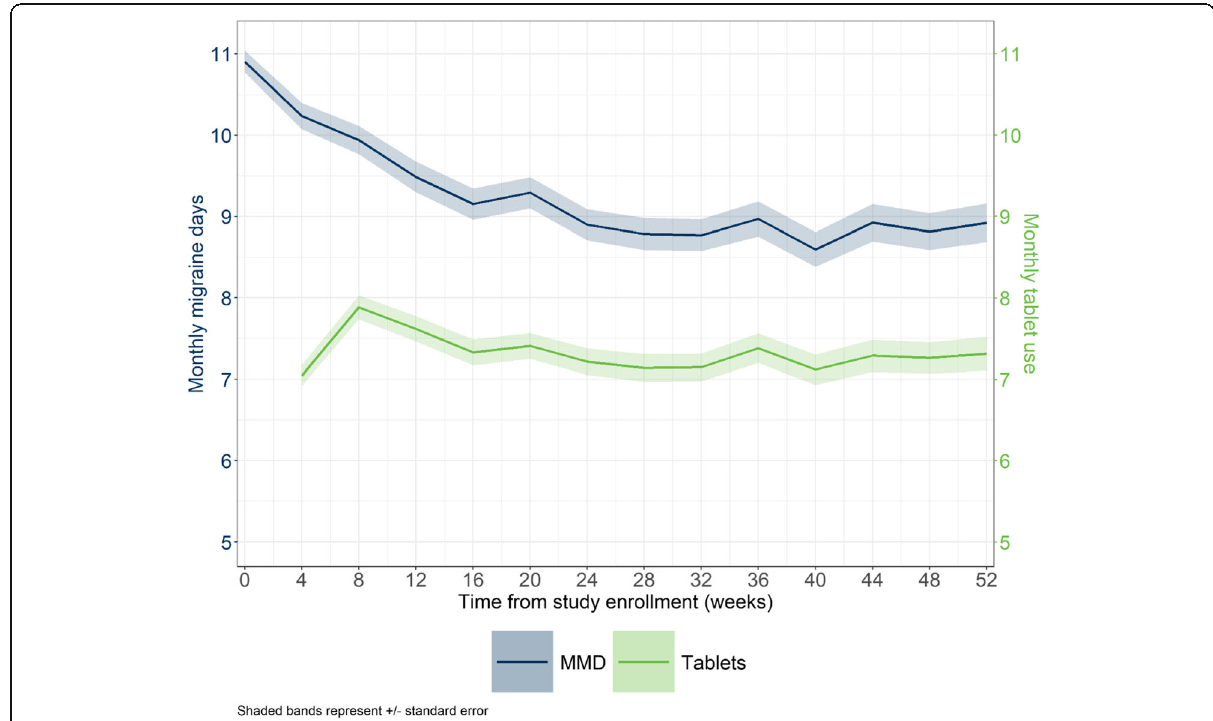
Fig. 1 Mean (SE) MMD and PRN rimegepant 75 mg tablet use over time for patients in BHV3000 – 201. MMD = monthly migraine days; PRN = as